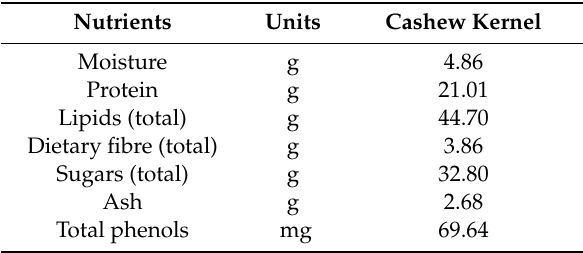
Table 1. Nutritional profile of cashew kernel samples from West Africa. Results are expressed for 100 g of cashew kernel